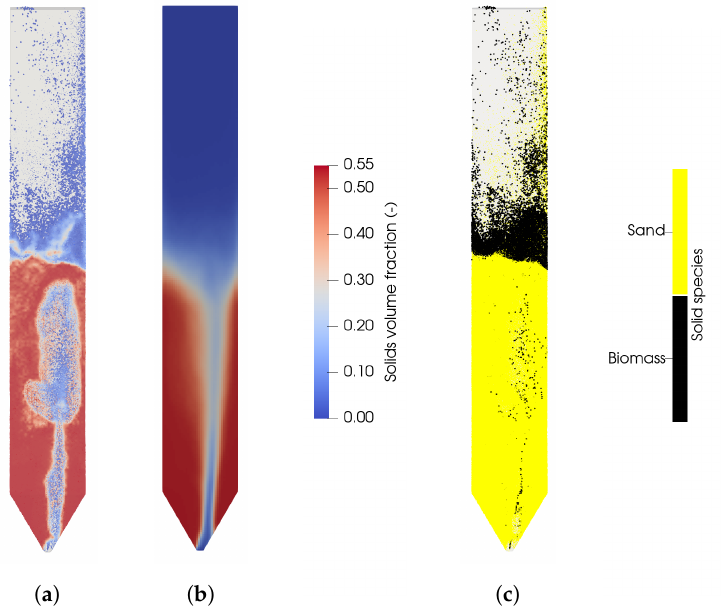
Figure 6. ( a ) Instantaneous solid volume fraction in the fuel reactor at t = 40 s. ( b ) Averaged solids concentration. ( c ) Instantaneous distribution of biomass and sand in the fuel reactor at t = 40